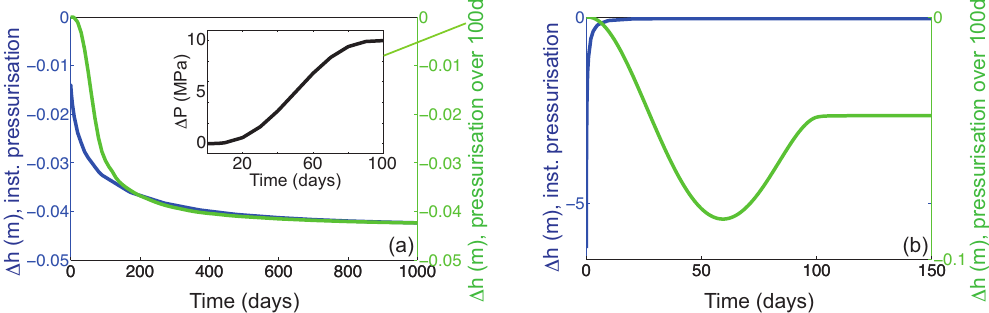
Figure 13. Comparison of the development of central hydraulic change with time due to an instantaneous chamber pressurization and a pressurization over 100d (with the same maximum pressurization value). (a) Pyroclastic aquifer, (b) lava flow aquifer. Inlet in (a) shows how the pressurization is stepped up over